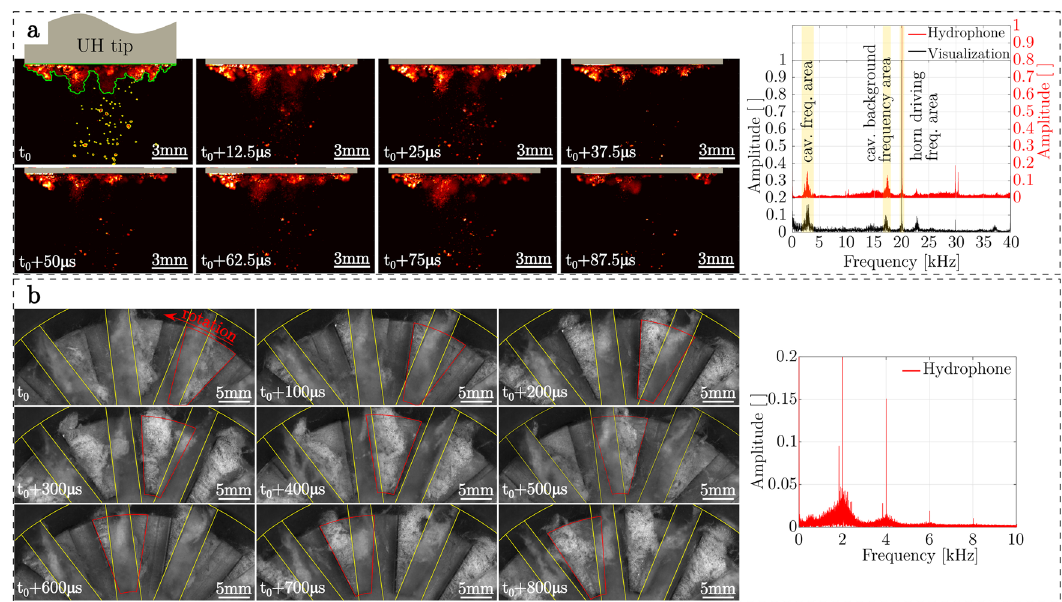
Fig. 6 High speed visualization and frequency analysis. High-speed visualization for a AC and b HC in distilled water. a AC cavitation time sequence captured under UH tip (left) with frequency spectrum based on visualization and pressure pulsation measurements (right). Contours in green and yellow lines in the fi rst AC cavitation frame show two distinct cavitation types: attached to UH tip, and detached bubbles. b HC cavitation sequence in HC device (left) with frequency spectrum based on pressure pulsation measurements (right). In HC visualization frames a rotor tooth is marked by a red line and a stator tooth by a yellow